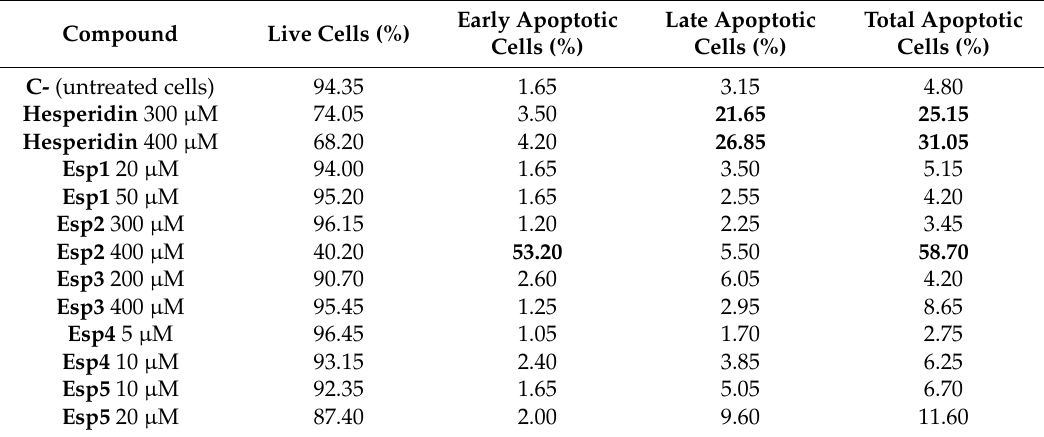
Table 6. Pro-apoptotic activity (%) of hesperidin and semi-synthetic analogues on K562 cells. Early Compound Live Cells (%)